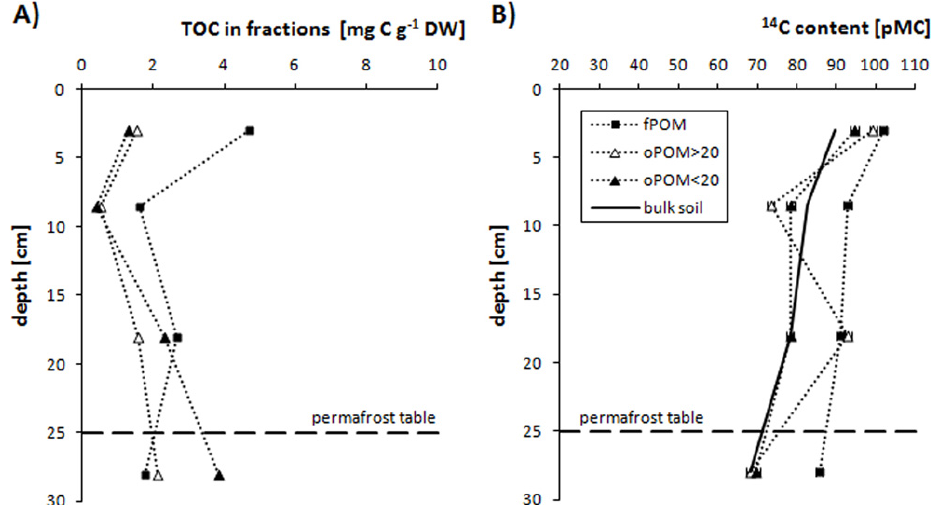
Fig. 2. Distribution of (A) organic carbon content (TOC) in density fractions related to fraction mass and (B) 14 C content (one-sigma measurement uncertainties are indicated by bars on each point) over